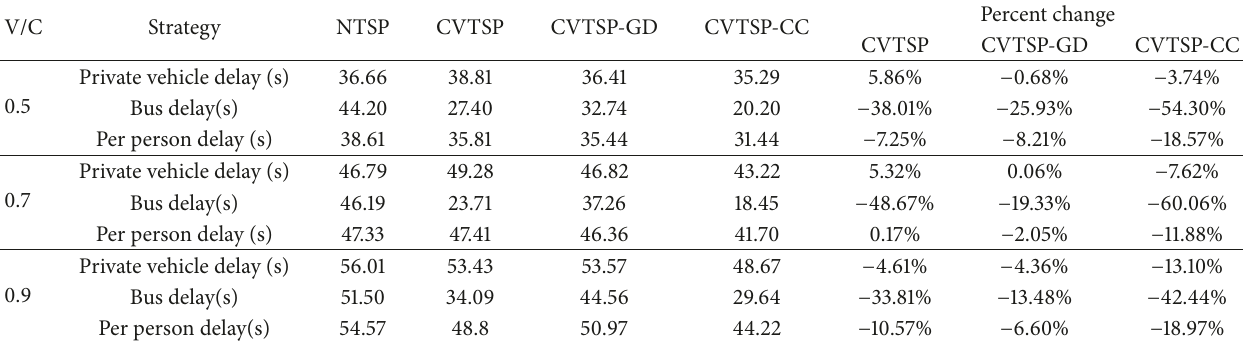
Table 2: The results of four